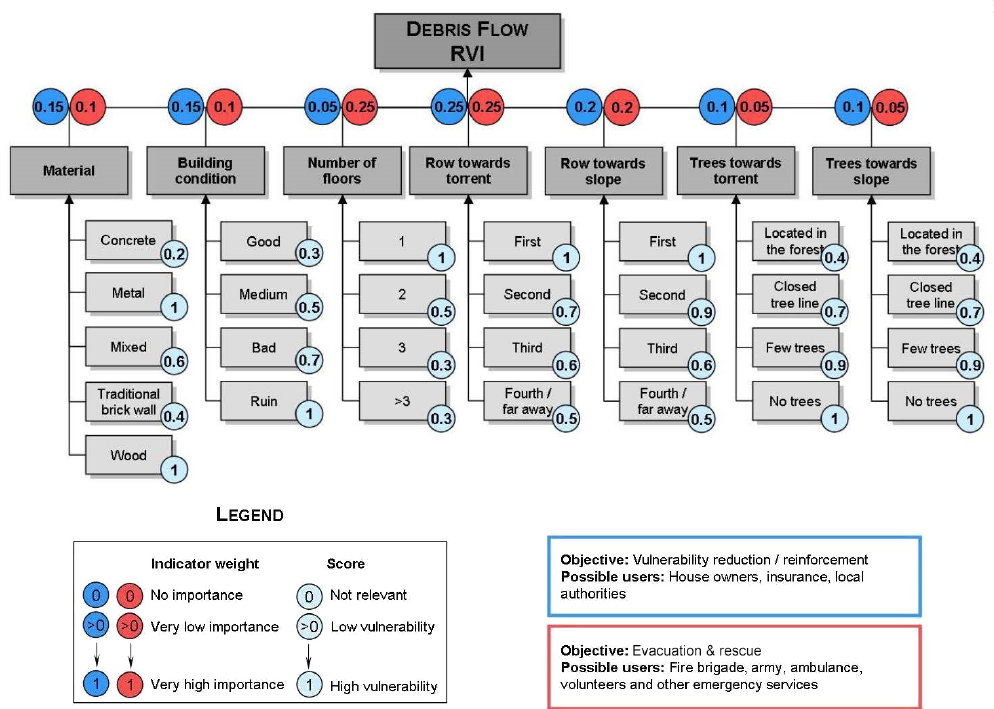
Figure 2. The IBM adapted for debris flow. The vulnerability indicators are demonstrated together with the weight index, which varies according to the objective of the vulnerability assessment and the end users (Kappes et al.,